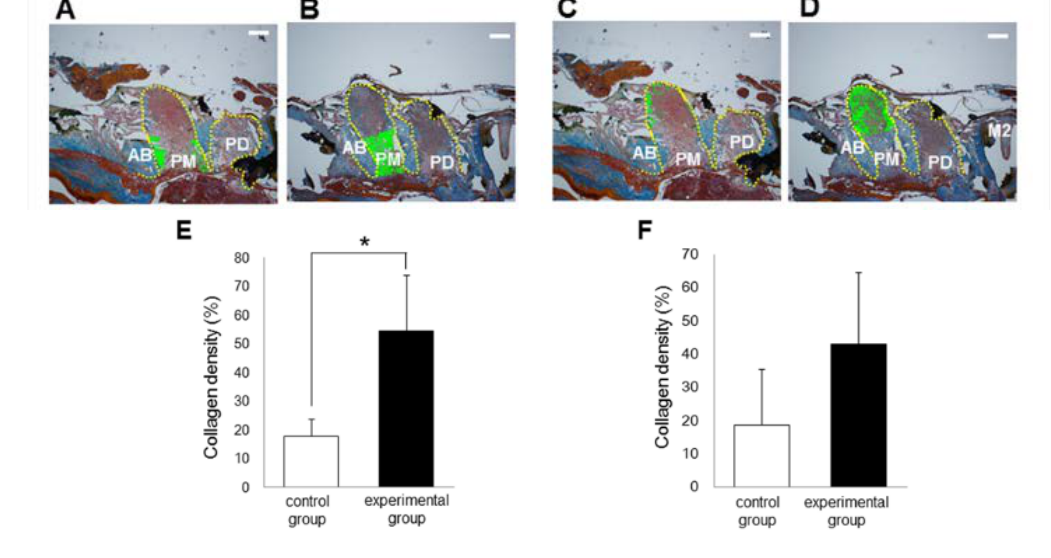
Figure 2. Photographs of alveolar sockets stained with Mallory’s aniline blue in the upper ( A : control group; B : experimental group) and the bottom ( C : control group; D : experimental group) regions at 3 days (Scale bar = 400 μm). In this study, we measured collagen density in the green regions. In the upper region, collagen density was higher in the experimental group than in the control group ( E ); in the bottom region, there were no significant differences in collagen dentistry between the groups ( F ). Bars represent means ± SD of 5–6 rats. * p < 0.05 vs. control group. Yellow dotted line: outline of alveolar socket. AB: alveolar bone; PM: alveolar socket at palatal mesial root of maxillary first molar; PD: alveolar socket at palatal distal root of maxillary first molar; M2: maxillary second